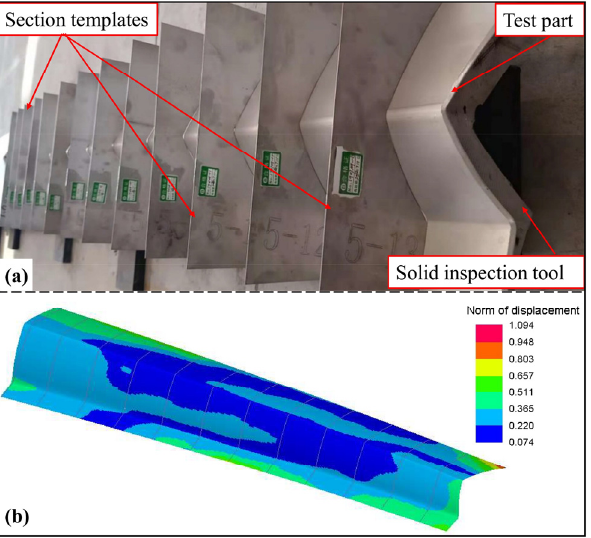
Figure 15. ( a ) Test part shape accuracy detection. ( b ) The springback of the numerical result.